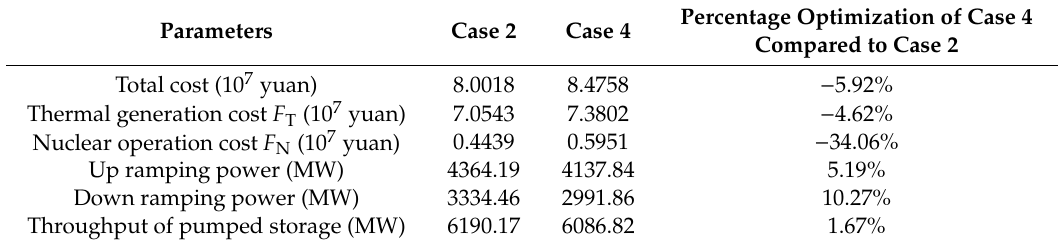
Table 4. Result comparison of Case 2 and Case 4 in a